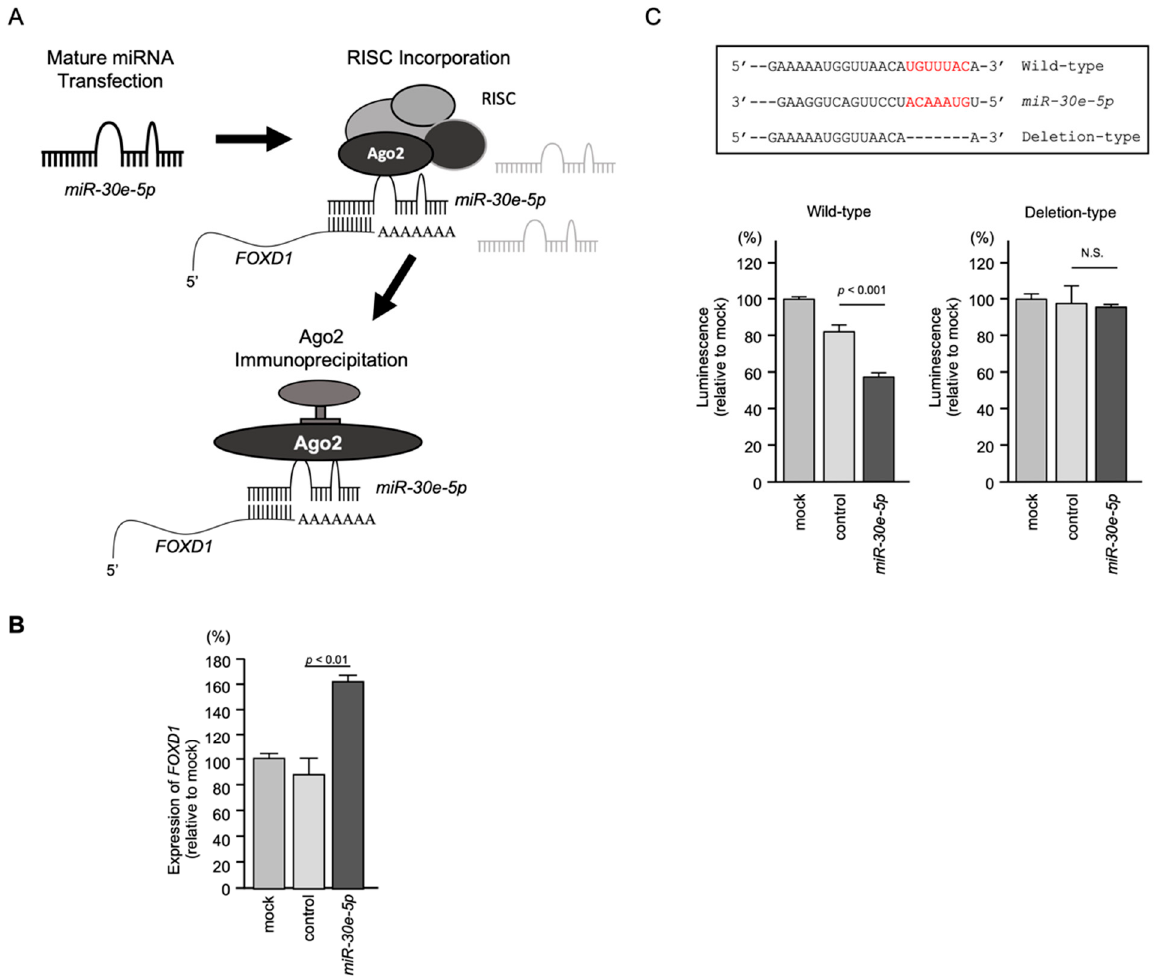
Figure 10. Isolation of RISC-incorporated FOXD1 mRNA by Ago2 immunoprecipitation. Direct regulation of FOXD1 expression by miR-30e-5p in HNSCC cells. ( A ) Schematic illustration of RIP assay. ( B ) qRT-PCR suggested FOXD1 mRNA was significantly incorporated into RISC. ( C ) TargetScan database analysis predicting putative miR-30e-5p -binding sites in the 3 ′ -UTR of FOXD1 (upper panel). Dual-luciferase reporter assays showed reduced luminescence activity after co-transfection of the wild-type vector and miR-30e-5p in Sa3 cells (lower panel). Normalized data were calculated as the Renilla/Firefly luciferase activity ratio (N.S.: not significant compared to control group).